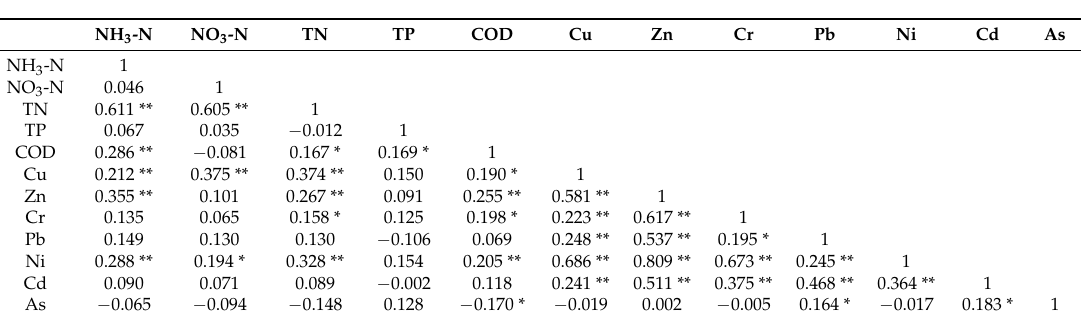
Table 4. Pearson correlation coefficients for the relationships between the concentrations of pollutants analyzed in samples from Haihe Basin.